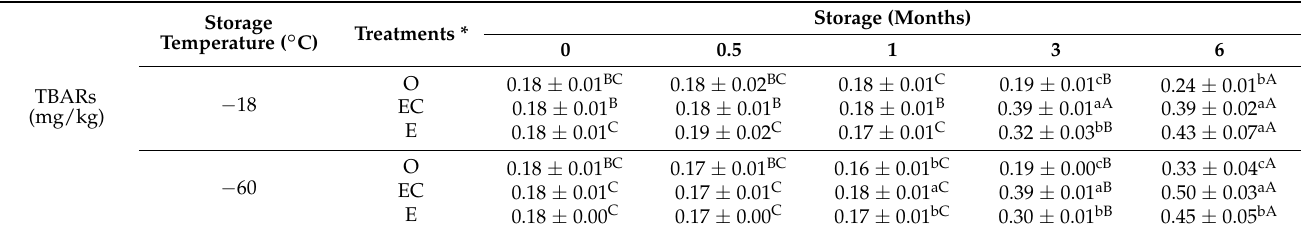
Table 8. TBARs (mg/kg) of meat analogs with different fat replacers (O, EC, and E) during the freezing storage ( − 18 ◦ C, − 60 ◦ C) for six months.